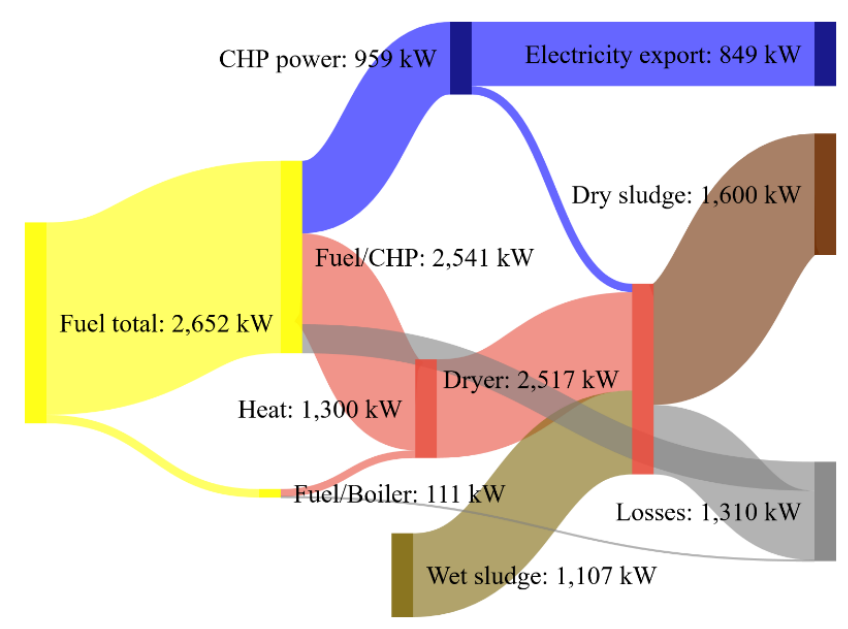
Figure 7. Energy flows in the drying plant—case 13.